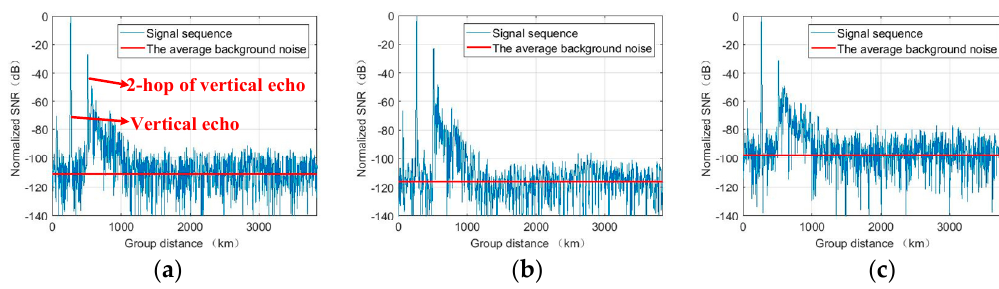
Figure 11. Normalized signal-to-noise ratio (SNR) of 5.2 MHz; ( a ) Channel 1; ( b ) Directly sum; ( c ) digital beamforming (DBF).